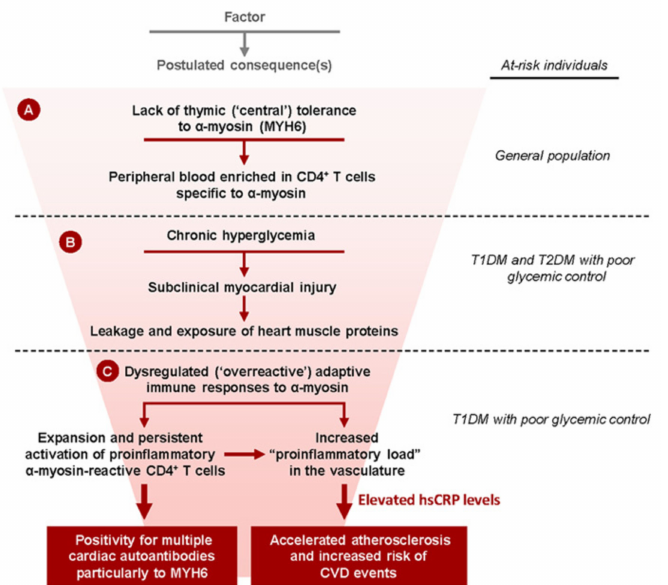
Figure 2. Proposed scheme of how chronic hyperglycemia is associated with cardiac autoimmunity and increased risk of cardiovascular disease (CVD) in patients with type 1 diabetes mellitus (T1DM). A: Absent thymic expression of the full-length α -cardiac myosin heavy chain ( α -myosin; encoded by MYH6) is associated with high frequencies of CD4+ T cells specific to α -myosin in the peripheral blood of individuals in the general population. B: In both patients with T1DM and patients with type 2 diabetes mellitus (T2DM), chronic hyperglycemia causes subclinical myocardial injury, leading to leakage and exposure of heart muscle proteins, including α -myosin, to the immune system. C: In patients with T1DM, with poor glycemic control, the dysregulated adaptive immune system overreacts to myocardial injury, leading to the expansion of proinflammatory CD4+ T cells specific to α -myosin and the development of autoantibodies to MYH6 and other cardiac antigens. This proinflammatory state is associated with elevated levels of the inflammatory marker, high-sensitivity C-reactive protein (hsCRP), and increased risk for accelerated atherosclerosis and CVD events. Sousa, GR et al. Circulation 2019; 139:730–43 (Ref.